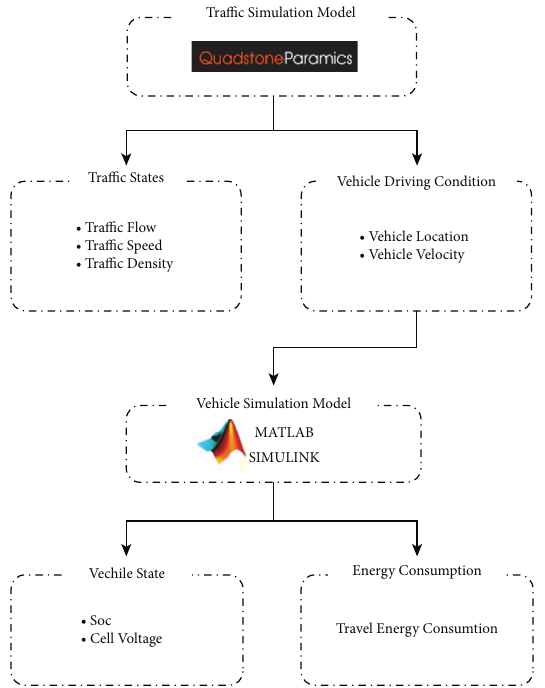
Figure 2: EV running data acquisition simulation platform.